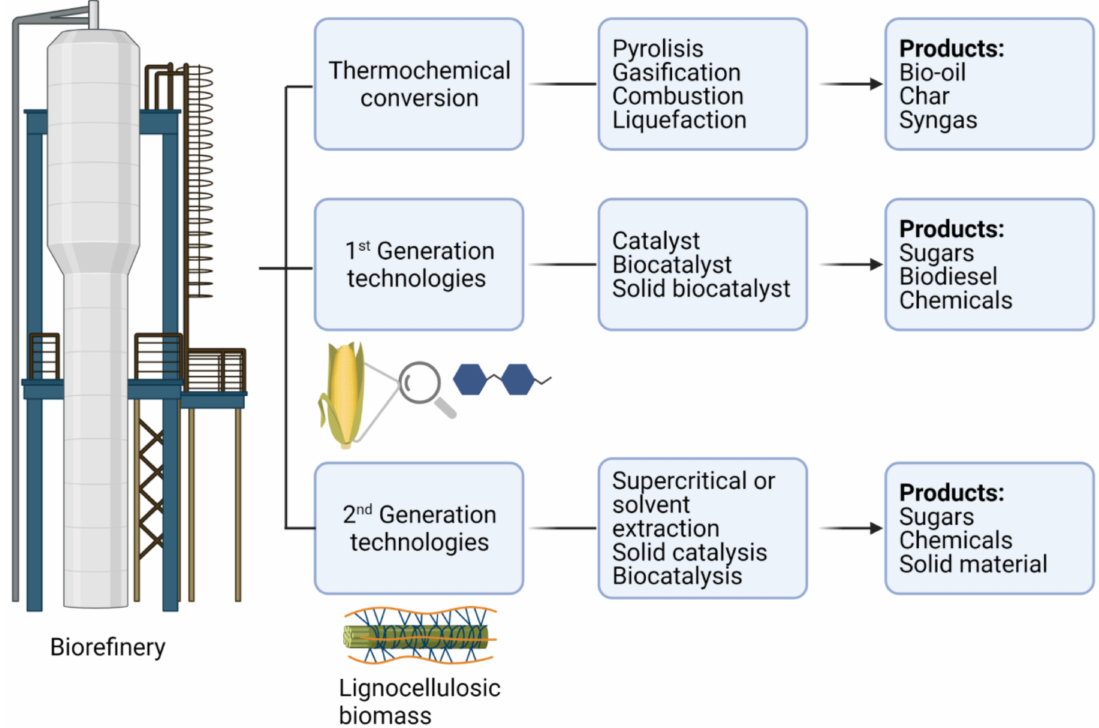
Figure 1. Biorefinery technologies according to different